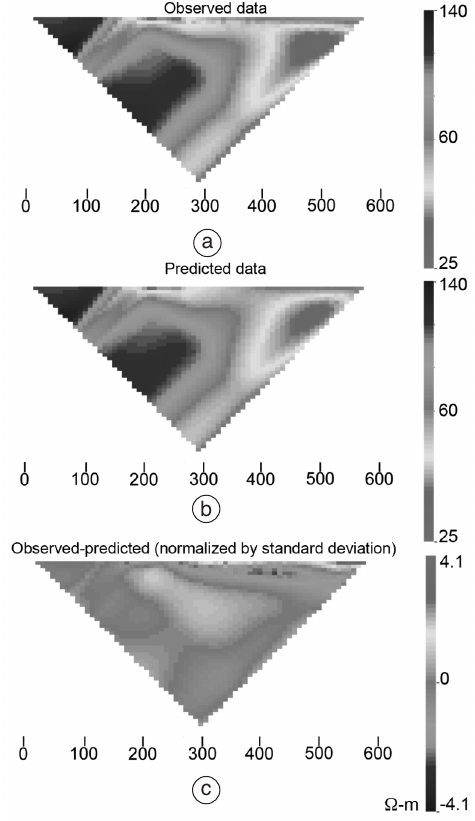
Fig. 11a-c. Result of geophysical inversion, pdL con- figuration, Model 1, at 2000 days: a) observed data; b) predicted data; c) difference between observed and predicted data.